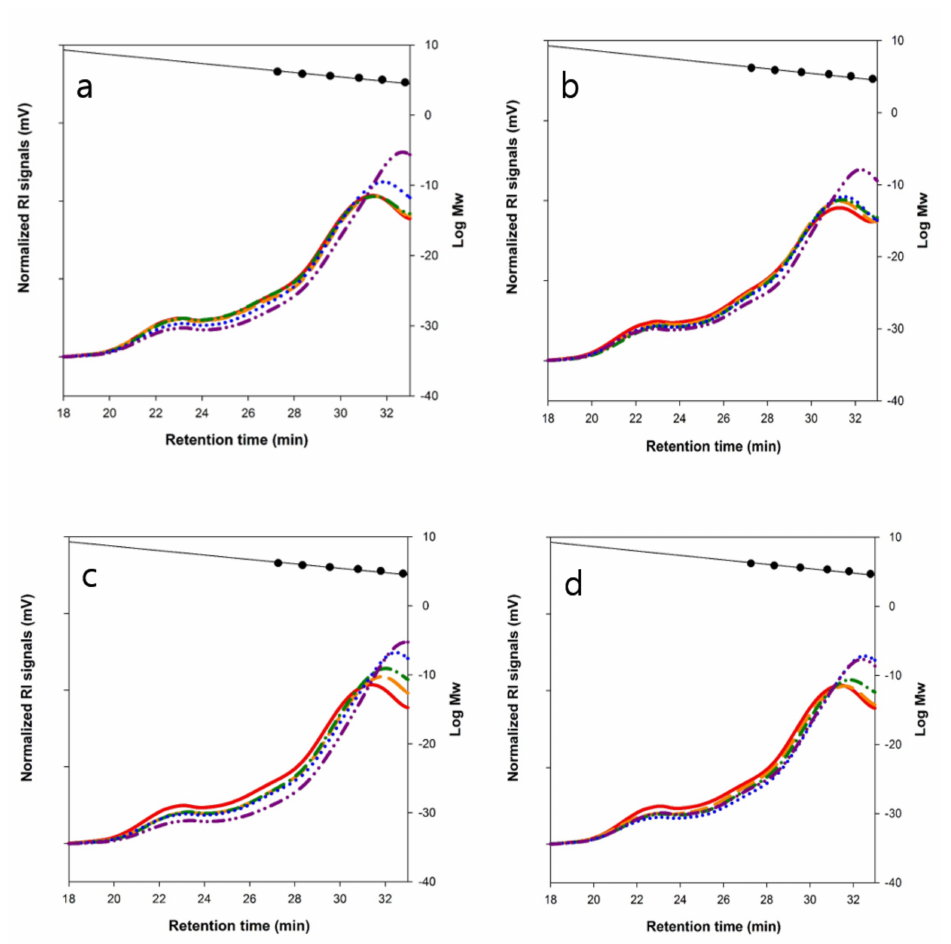
Figure 1. High-performance size-exclusion chromatography (HPSEC) analysis of